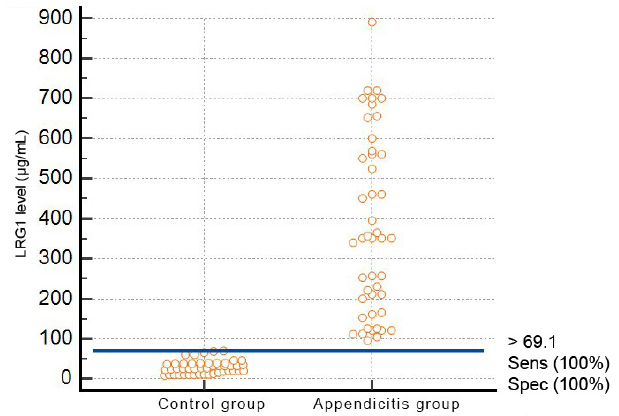
Figure 2. One hundred percent accurate separation of acute appendicitis vs. non-appendicitic cases based on the >69.1 µg/mL cut-o ff for LRG1 levels.